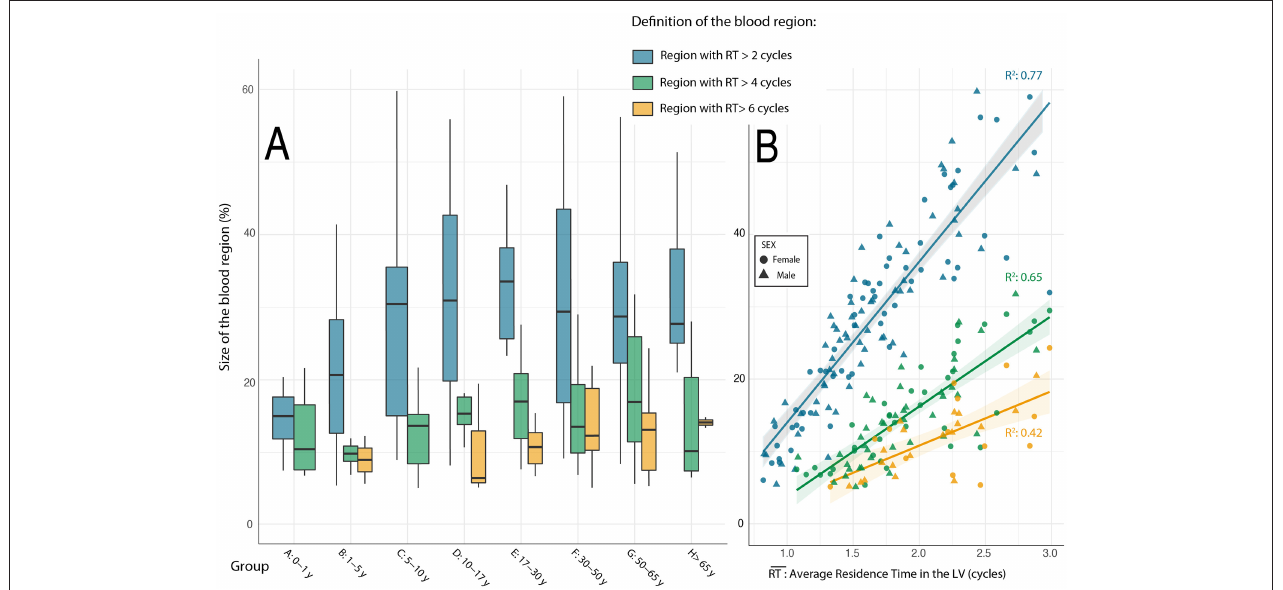
FIGURE 3 | Relationship between age groups and the size of blood volumes with longest residence time. (A) Changes in the size of blood regions with age groups. (B) Relations between average residence time of blood in the LV and the size of retained blood volumes.